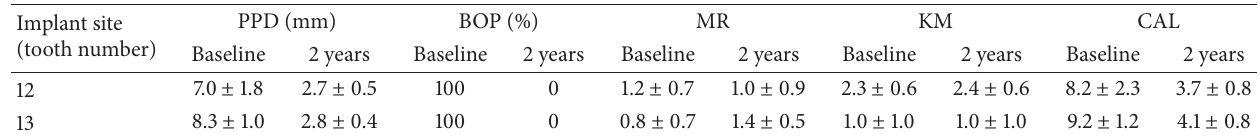
Table 1: Postsurgical clinical observations taken at baseline and 2 years. Baseline values were obtained immediately before surgery. Results are expressed as Mean ± SD and are the average values of the four areas investigated. BOP = bleeding on probing, PD = probing depth, MR = mucosal recession, CAL = clinical attachment level, and KM = keratinized mucosa width.